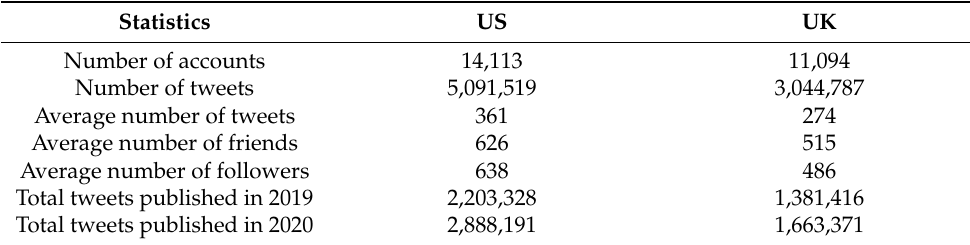
Table 1. The characteristics of the study population across the study period (2019–2020).